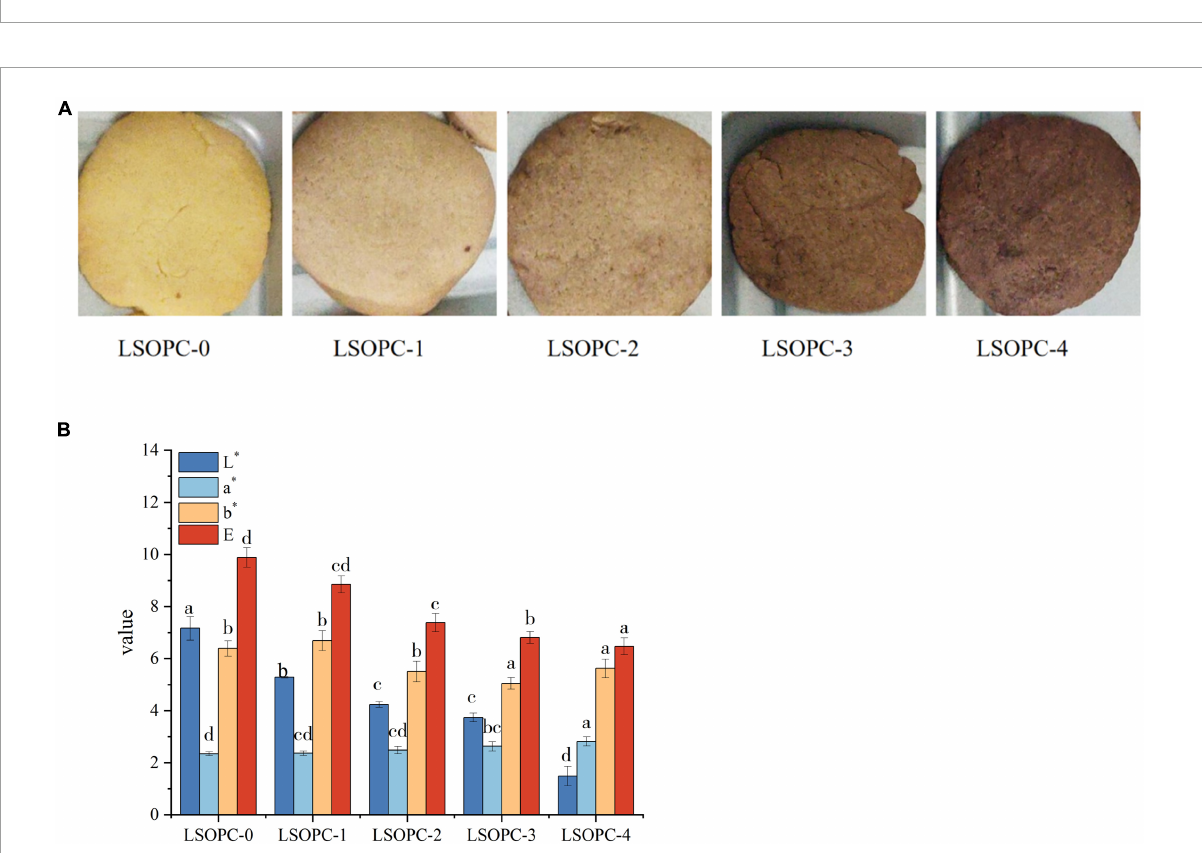
FIGURE6 Original images of cookies (A) . Chromatic value of cookies (B) . Significant differences ( p < 0.05) of data values were indicated by different